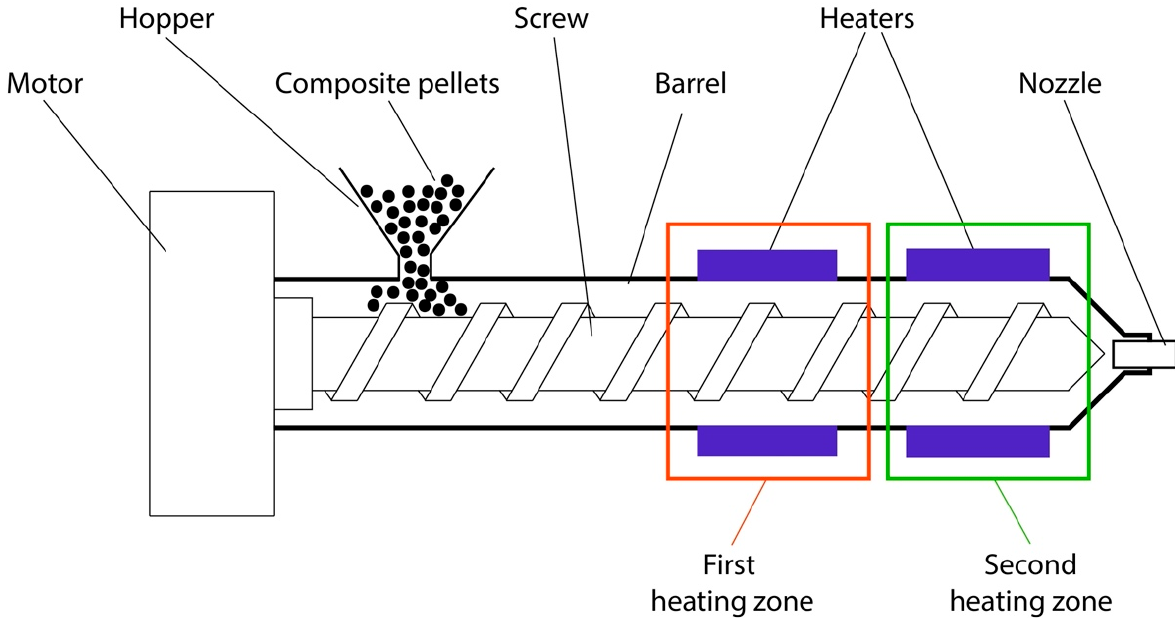
Figure 2. Schematic diagram of a single screw extruder used for the composite filaments fabrica- tion.